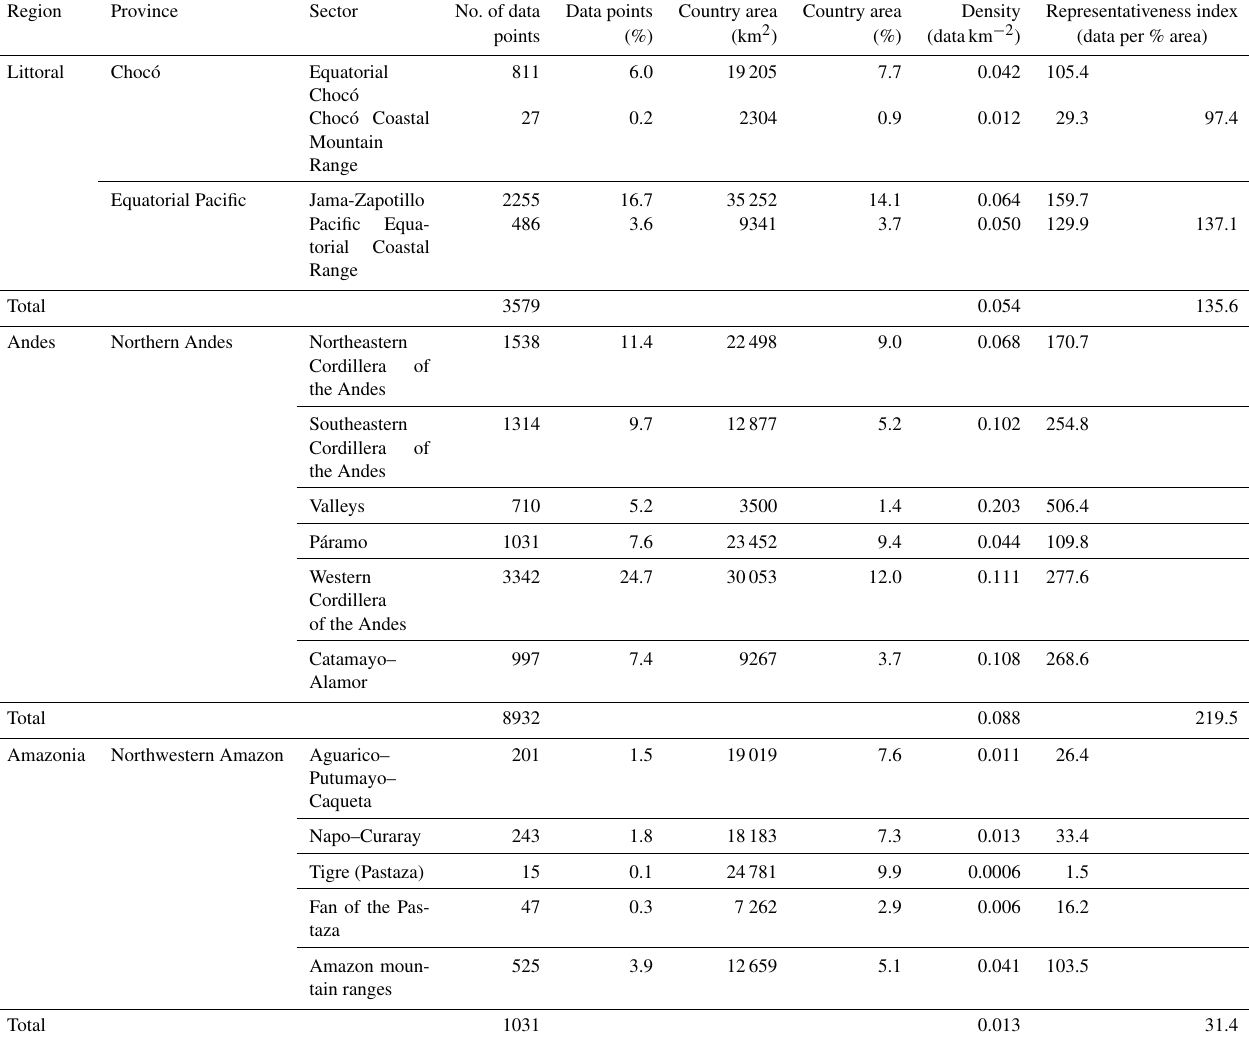
Table 4. Distribution of SOC data points per ecosystem sector (vegetation formation) according to the Ministerio del Ambiente del Ecuador